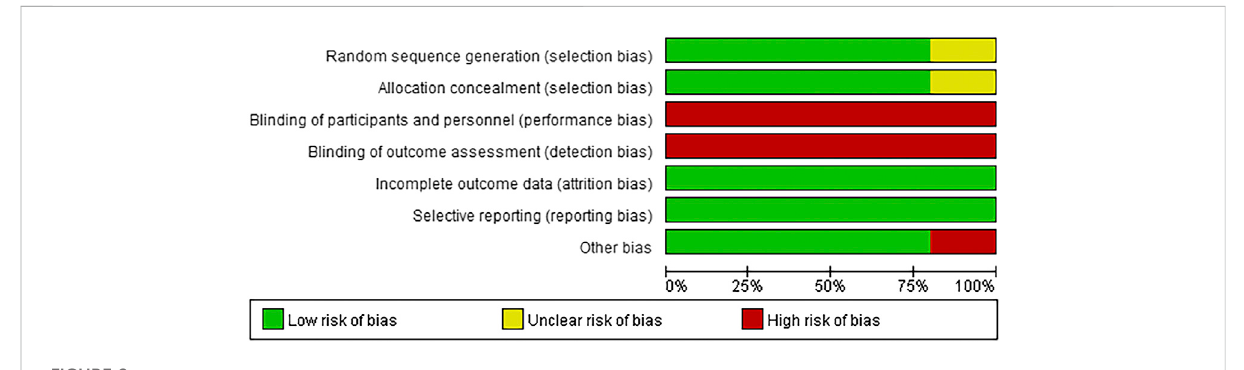
FIGURE 2 Risk assessment of bias in all included studies:risk of bias